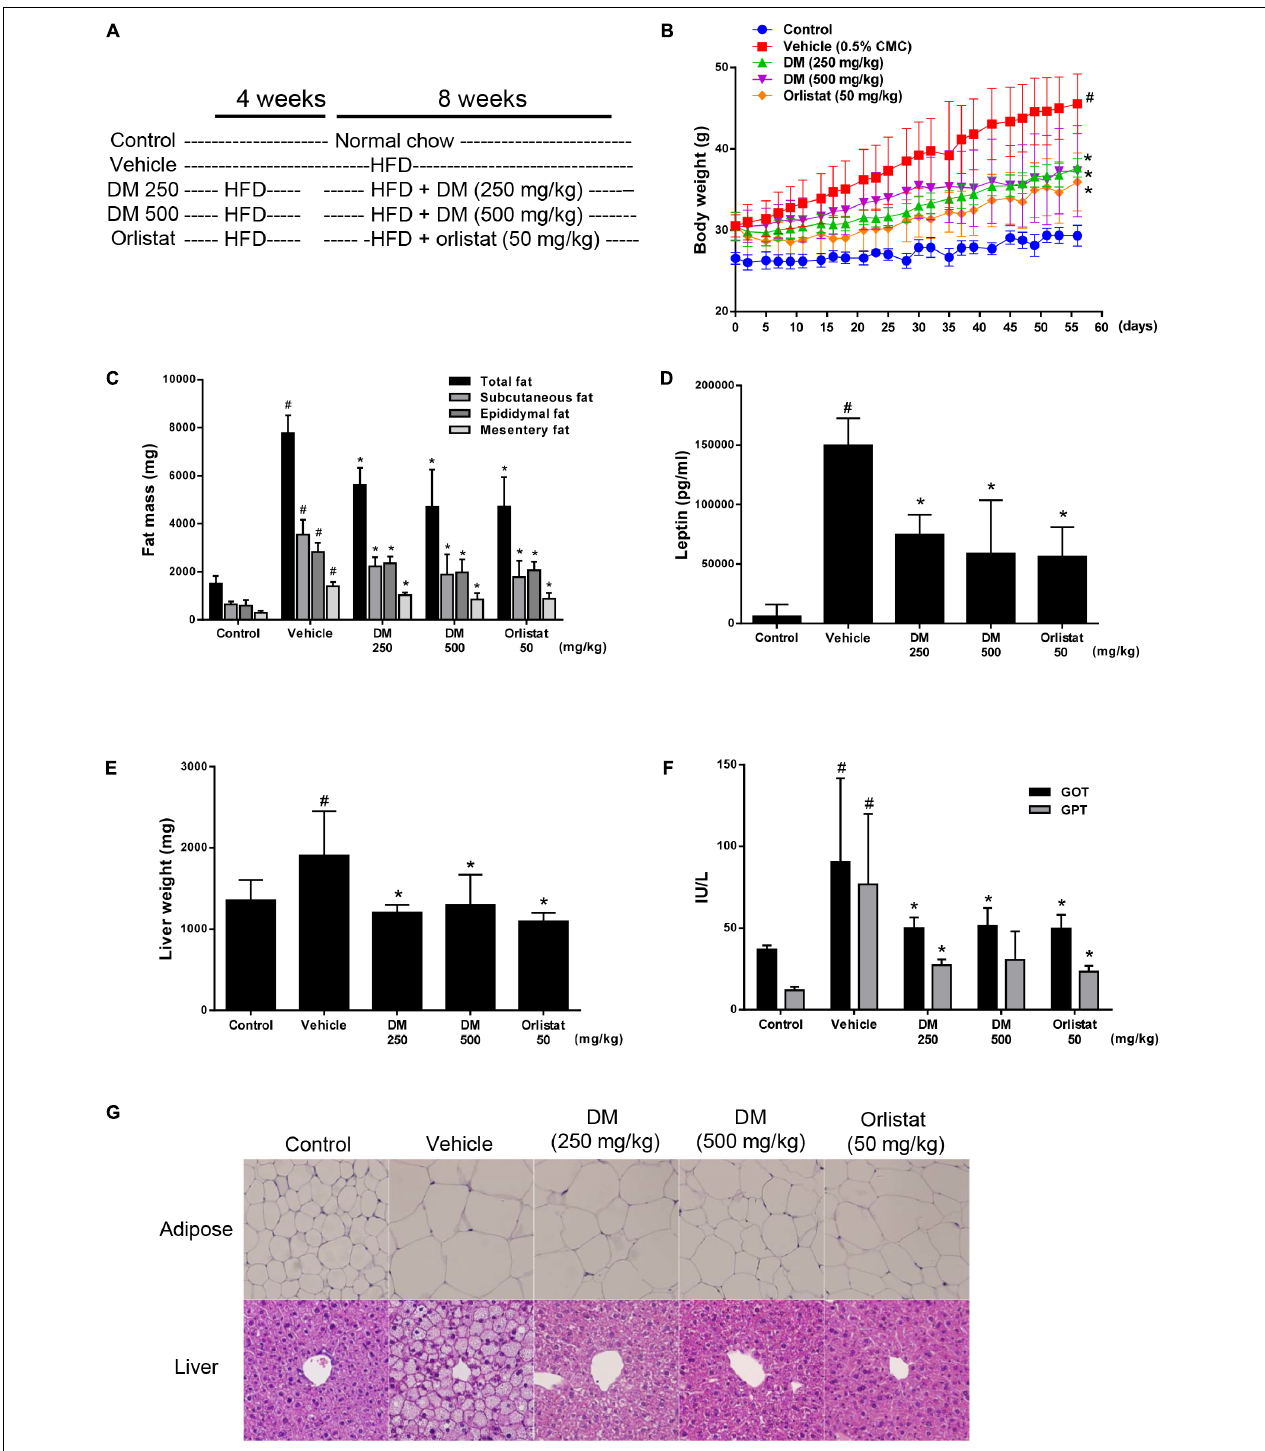
FIGURE 6 | Effects of DM on HFD-induced obesity in C57BL/6 mice. DM (250 or 500 mg/kg) or orlistat (50 mg/kg) were administered by oral gavage for 8 weeks while the mice were fed the HFD. (A) Experimental outline. (B) Body weight was measured 3 times per week. The group that received HFD alone ( (cid:4) ) showed steady body weight gain, while the DM-( (cid:78) or (cid:72) ) and orlistat-treated ( (cid:7) ) groups showed significantly attenuated body weight gain. (C) Adipose tissue weight of subcutaneous, epididymal, and mesentery fat. (D) Amount of leptin in plasma measured by ELISA. (E) Liver weight. (F) Plasma levels of GOT and GPT measured using a chemical analyzer. (G) H&E-stained images of liver and subcutaneous adipose tissue samples from the normal diet (control), vehicle-treated, DM-treated, and orlistat-treated groups. The results are expressed as the mean ± SD for each group ( n = 8). # p < 0.05 compared with the control group; ∗ p < 0.05 compared with the HFD-treated vehicle